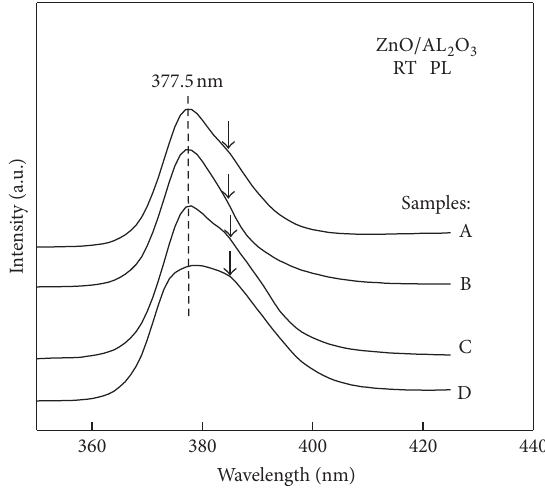
F 2: UV PL spectra of the grown ZnO thin �lms at room temperatures.